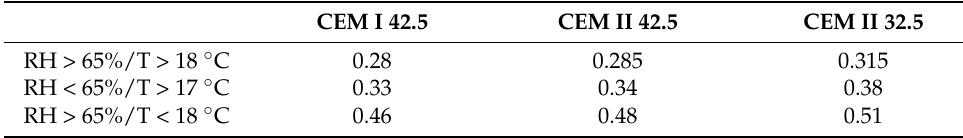
Table 22. Environmental parameter enp.